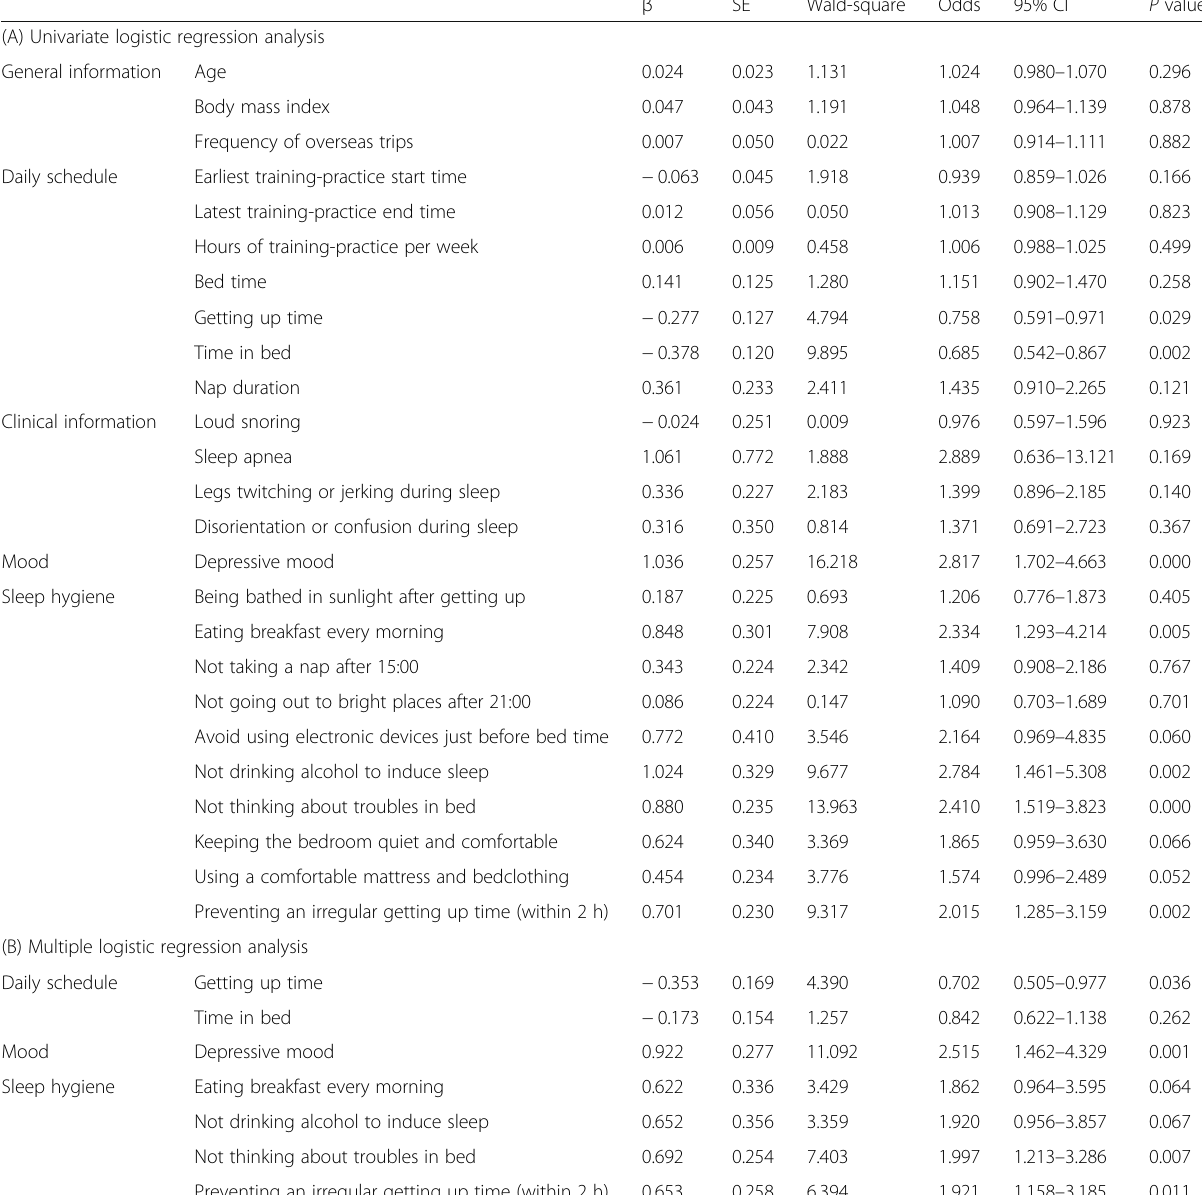
Table 7 The associations amongst sex, age, body mass index, experience of overseas trips, training-practice schedule, depressive mood and sleep habits, and poor sleep quality (PSQI global score > 5.5) in females β SE